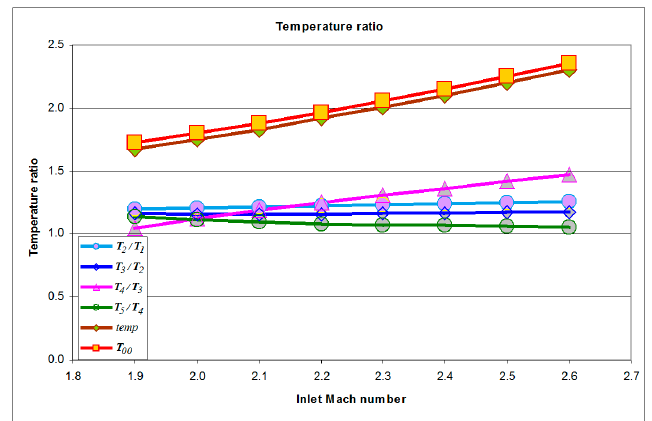
Figure 9. Local values of the static temperature ratio after isentropic compression ( T 00 ), after the shockwave system ( T 03 / T 00 ), and the static temperature at the combustion chamber inlet ( T 5 / T 1 ). At the same ramp angles in the main rotor inlet channel, for different inlet Mach numbers, the oblique shockwave inclination varied, as shown in Figure 10, which required modification of the engine inlet geometry or operation with a non-optimal configuration with side effects.